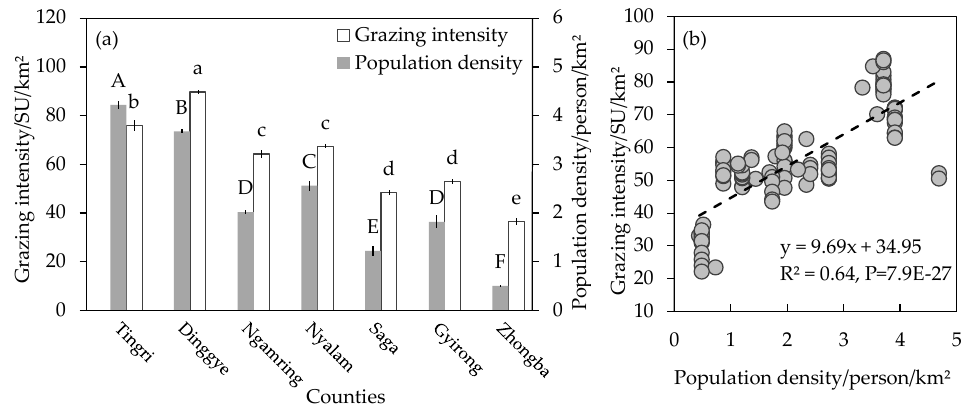
Figure 8. ( a ) Comparisons of the grazing intensity and population density between 7 counties and ( b ) their relationships during 2000 – 2018. Different lower-case and upper-case letters indicate significant differences in grazing intensity and population density between counties, respectively, by using the Tukey ’s HSD tests at α = 0.05.